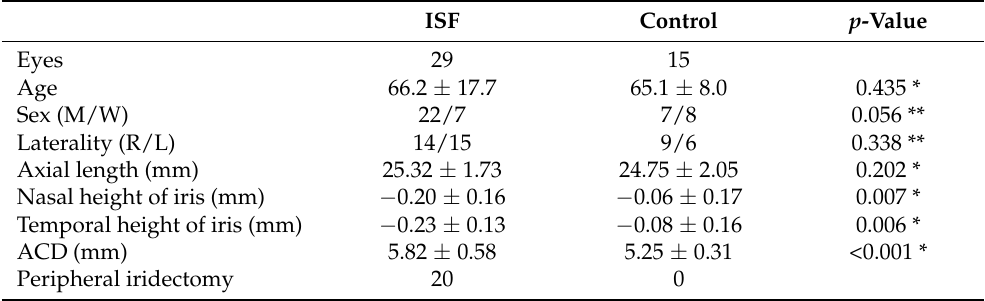
Table 1. Baseline characteristics between the eyes after intrascleral fixation and vitrectomy combined with cataract surgery.